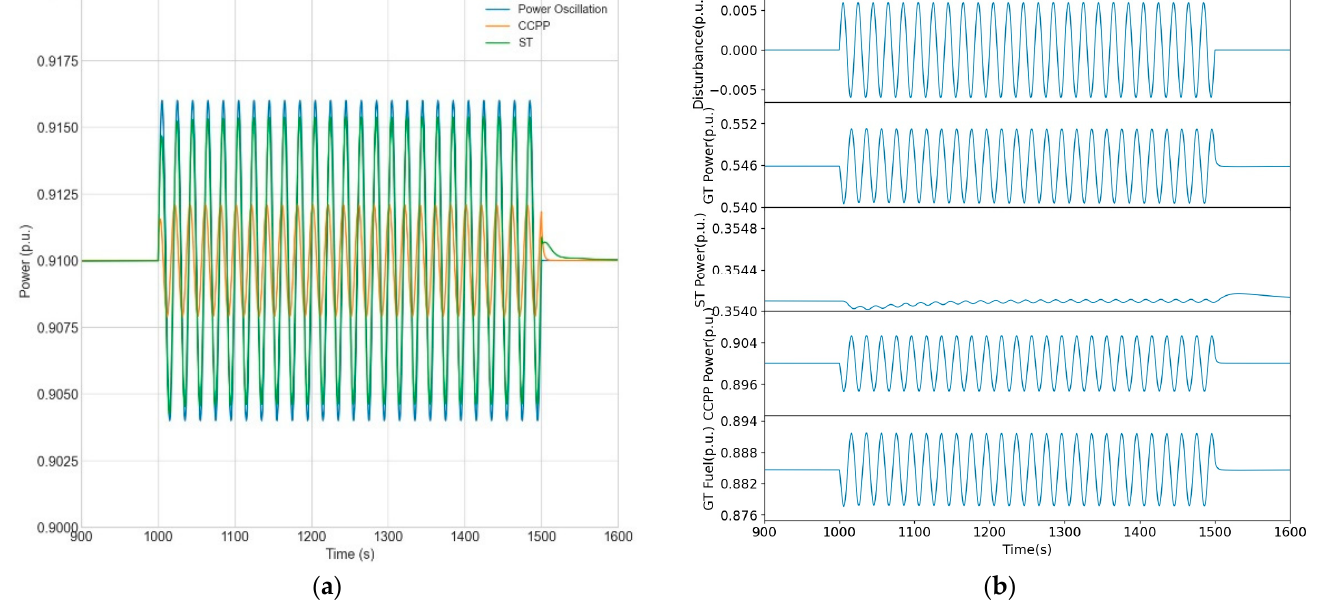
Figure 8. Simulation of oscillating load mutation. ( a ) Oscillating load mutation for CCPP and ST. ( b ) Load variation for CCPP.